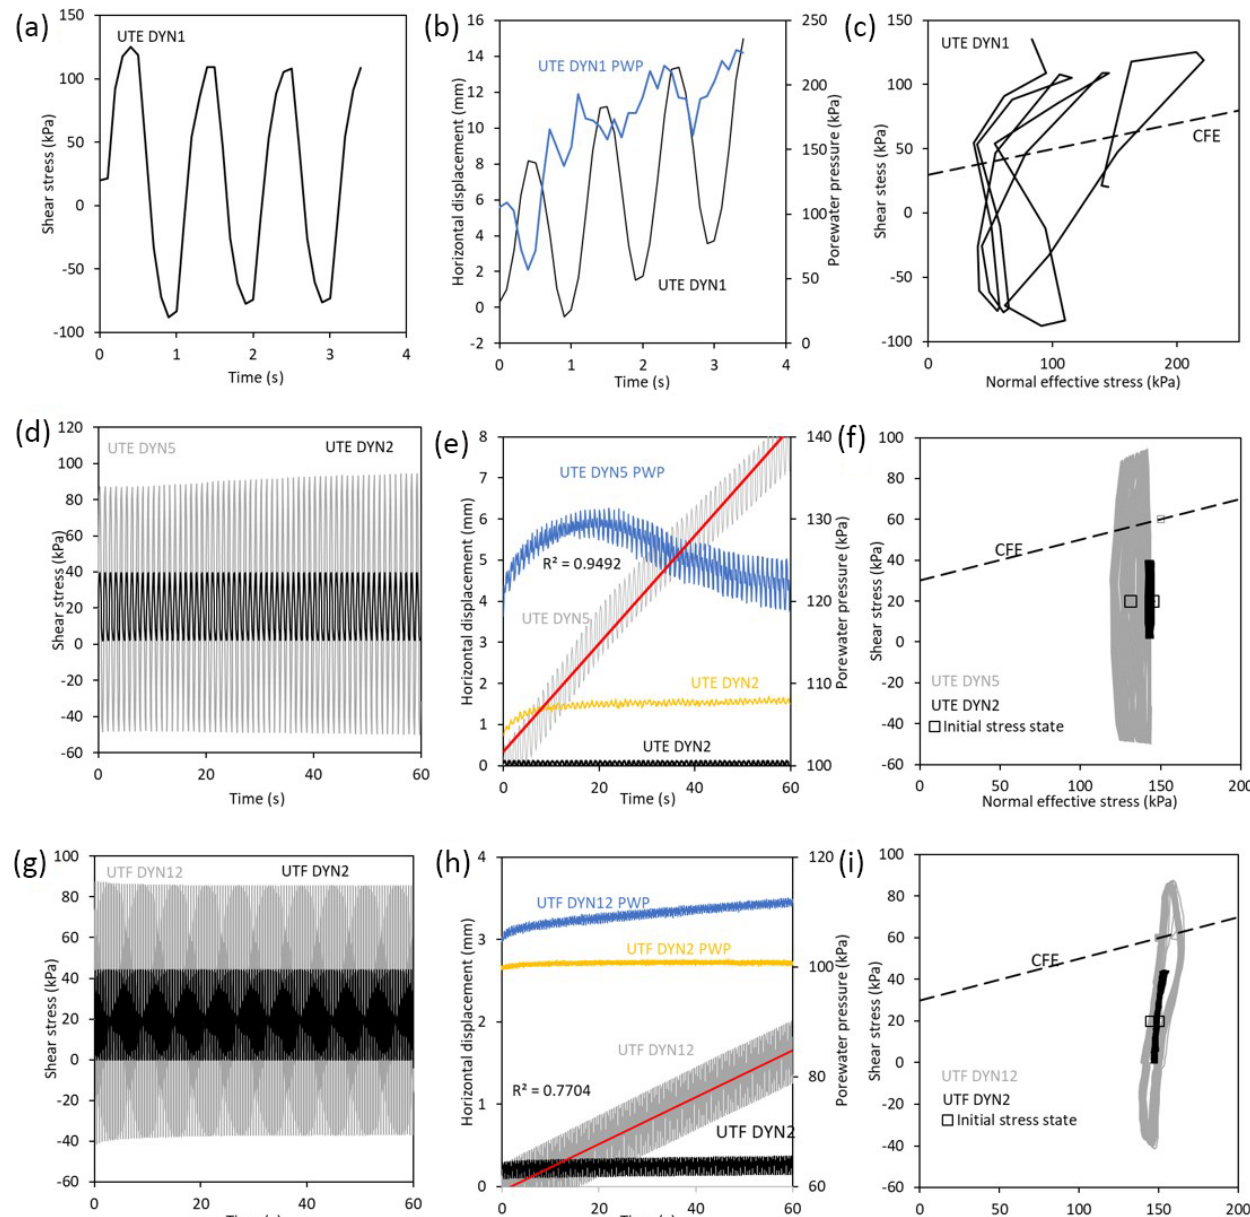
Figure 9. Dynamic shear experiments. (a) Dynamic shear stress cycles applied at 1Hz during experiment UTE DYN1. (b) Displacement and porewater pressure response measured during experiment UTE DYN1. (c) Sample stress paths in relation to the conventional failure envelope (CFE) during experiment UTE DYN1. (d) Dynamic shear stress cycles applied at 1Hz in experiments UTE DYN2 and UTE DYN5. (e) Displacement and porewater pressure response measured during experiments UTE DYN2 and UTE DYN5. (f) Sample stress paths in relation to the conventional failure envelope (CFE) during experiments UTE DYN2 and UTE DYN5. (g) Dynamic shear stress cycles applied at 2Hz during experiments UTF DYN2 and UTF DYN12. (h) Displacement and porewater pressure response measured during experiments UTF DYN2 and UTF DYN12. (i) Sample stress paths in relation to the conventional failure envelope (CFE) during experiments UTF DYN2 and UTF